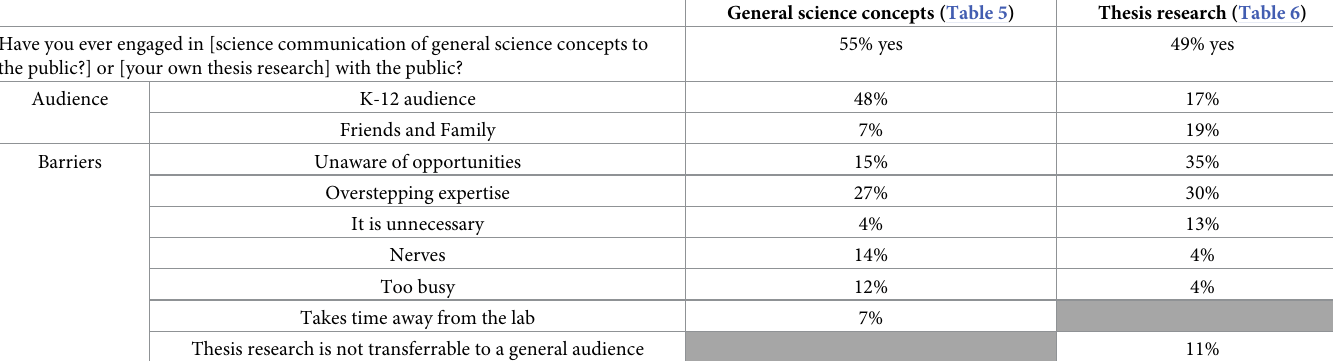
Table 7. Differences in audience types and qualitative responses between communicating general science concepts or thesis research as described by participants. General science concepts (Table 5) Thesis research (Table